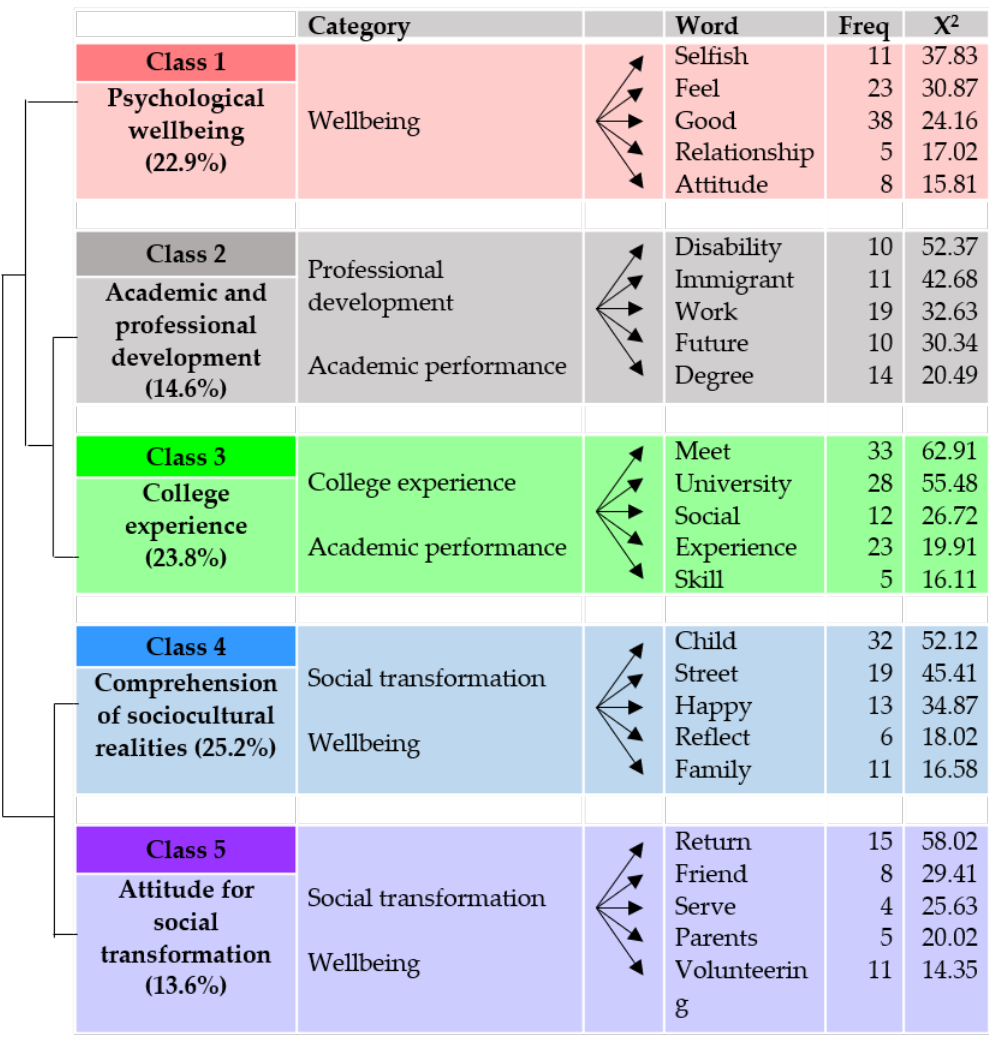
Figure 6. Distribution of classes and their respective units of meaning (post-interviews).